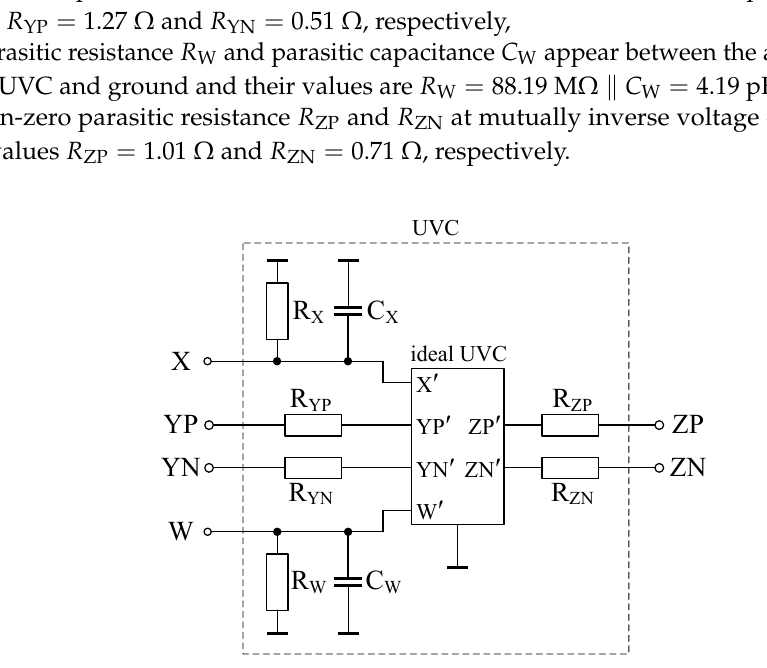
Figure 2. Main parasitic resistance and capacitance of the